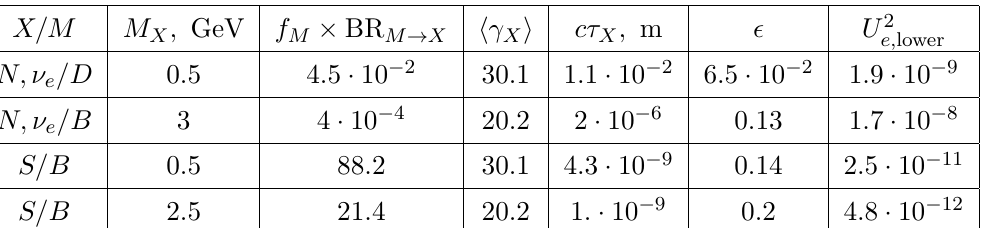
Table 5 . Table of parameters used in simple analytic estimation of the lower bound (2.1) for the SHiP experiment for particular masses of the HNLs with the pure electron mixing and the scalars. The columns are as follows: the type of the particle X and the mother particle, the branching ratio of the production of X at (cid:18) 2 = 1, average (cid:13) factor, proper decay length c(cid:28) X at (cid:18) 2 X overall e(cid:14)ciency (6.1), the mixing angle at the lower bound estimated as N N is given by (2.1). events ; lower